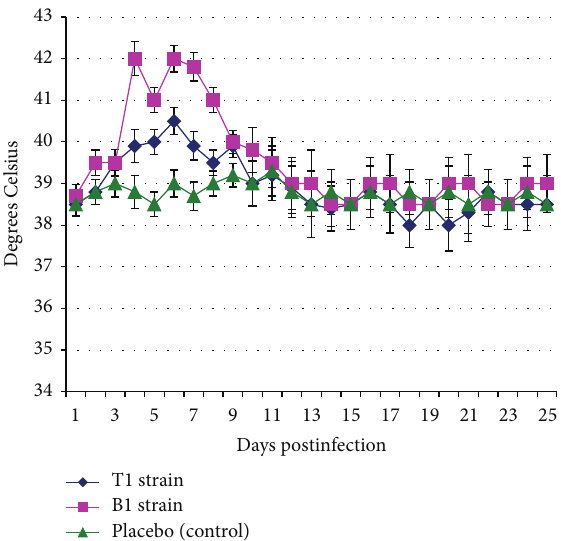
Figure 3: The data on the dynamics of rectal temperature in 4–6- month-old calves after aerosol challenge by bovine viral diarrhea virus cytopathic strains of subtype 1b with the dose of 6 log 10 TCD 50 . The values are presented as 𝑀 ± 𝐼 95 ( 𝑀 , mean value; 𝐼 95 , 95% confidence interval) for 𝑛 = 3 , the number of animals per time point (1–10 days postinfection, p.i.); 𝑛 = 2 , the number of animals per time point (11–25 days p.i.); values obtained for both strains 4–9 days p.i. are higher than in the control according to Mann-Whitney 𝑈 test and Student’s 𝑡 -test at 𝑝 ≤ 0.05 ; values obtained for B1 strains 2 and 4–8 days p.i. are higher than for T1 strain according to Mann- Whitney 𝑈 test and Student’s 𝑡 -test at 𝑝 ≤ 0.05